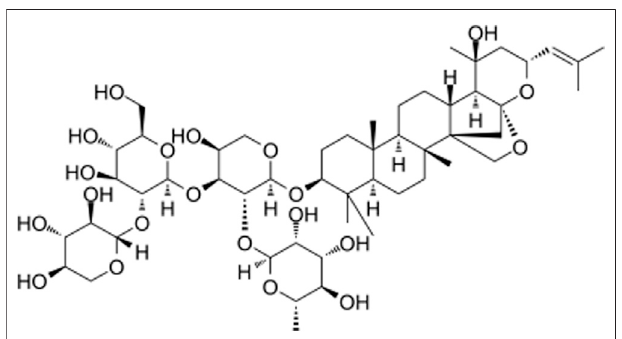
FIGURE 1 | Molecular structure of Jujuboside